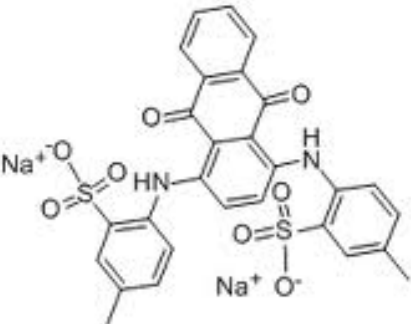
Figure 1. Structure of Acid Green